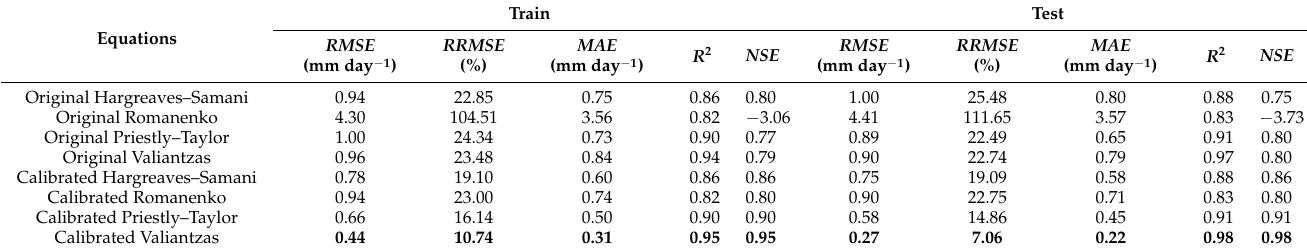
Table 8. The statistical indicators computed for the original and calibrated empirical equations in the training and test phases (Shiraz station).